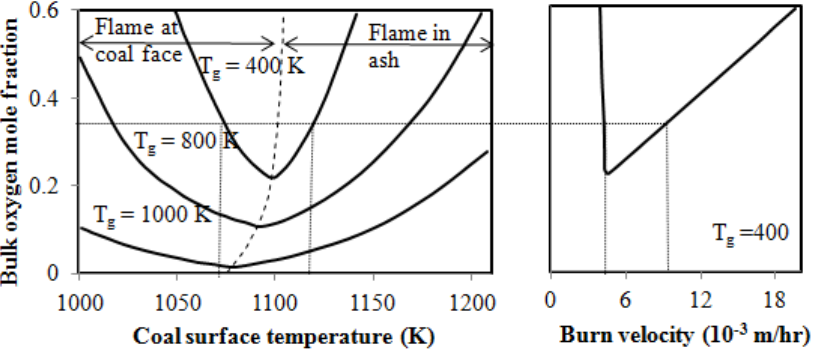
Figure 40. Effect of bulk gas temperature of the combustion of wet Wyodak coal [78].